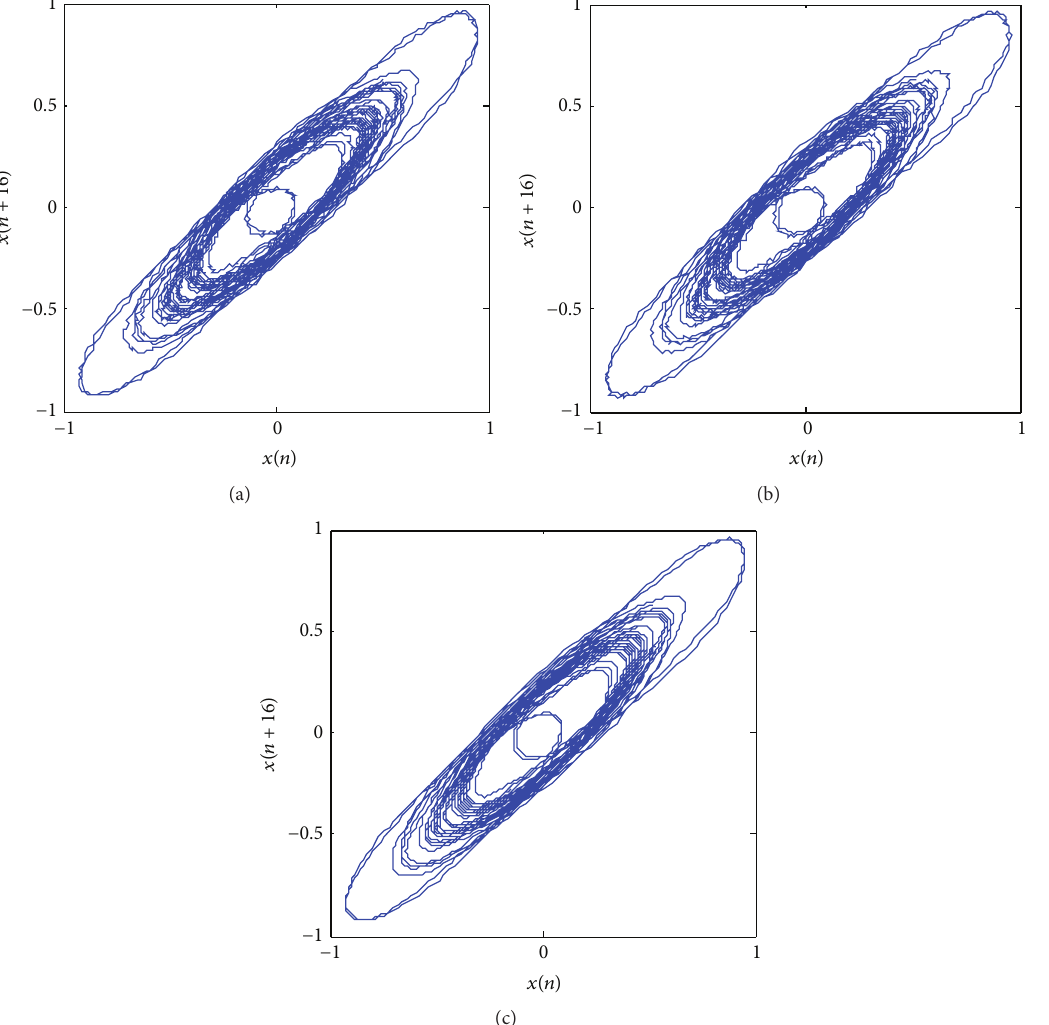
Figure14:Thedenoisedphasediagramsofvibrationsignals.(a)Waveletweightedthresholdmethod.(b)TraditionalEEMD.(c)Theproposed method.